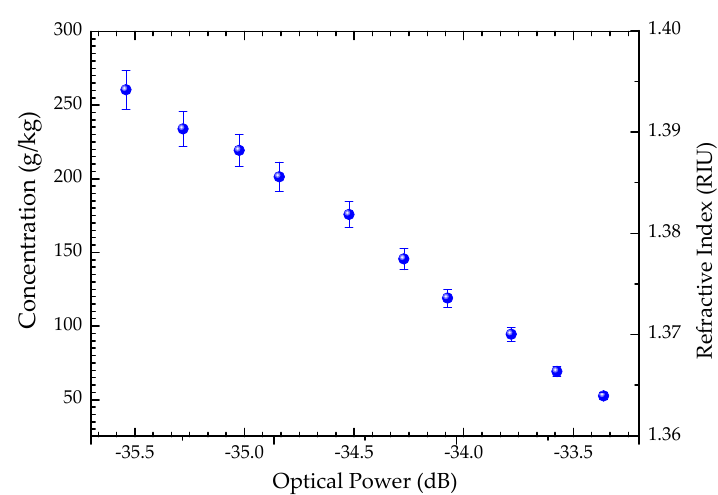
Figure 3. Optical power dependence on paracetamol concentration and respective refractive index.